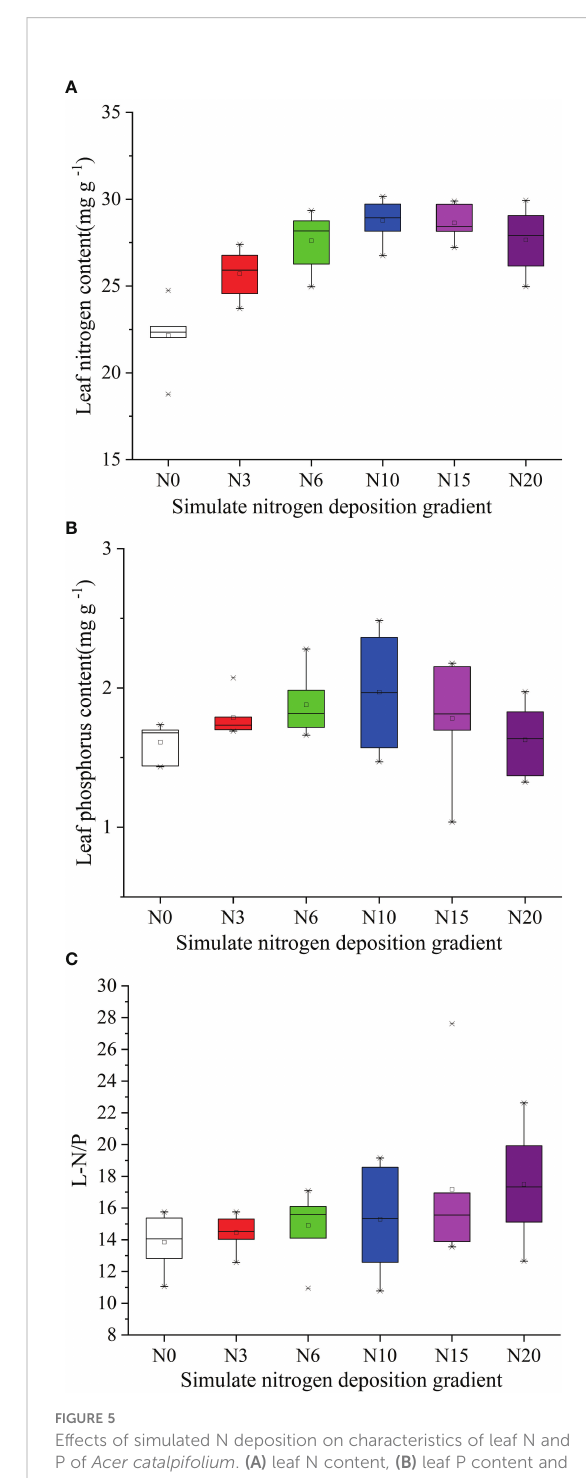
FIGURE 5 Effects of simulated N deposition on characteristics of leaf N and P of Acer catalpifolium . (A) leaf N content, (B) leaf P content and (C) leaf N/P